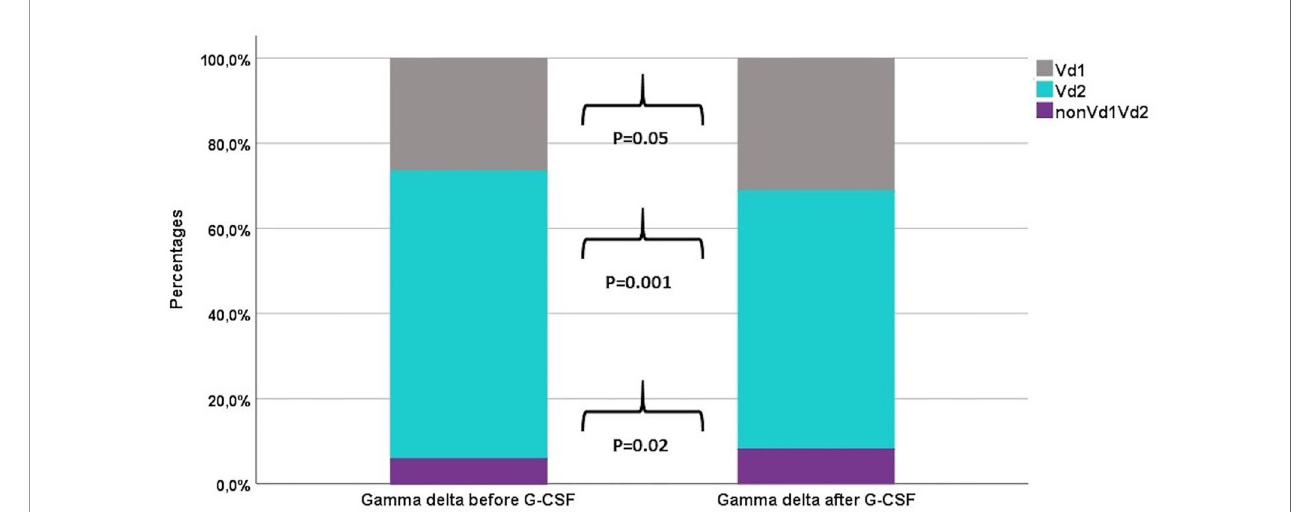
FIGURE 2 | The distribution of TCR gd cell subsets before and after G-CSF stimulation in peripheral blood of healthy donors, n=49. Each compartment is constructed by the use of median percentages.